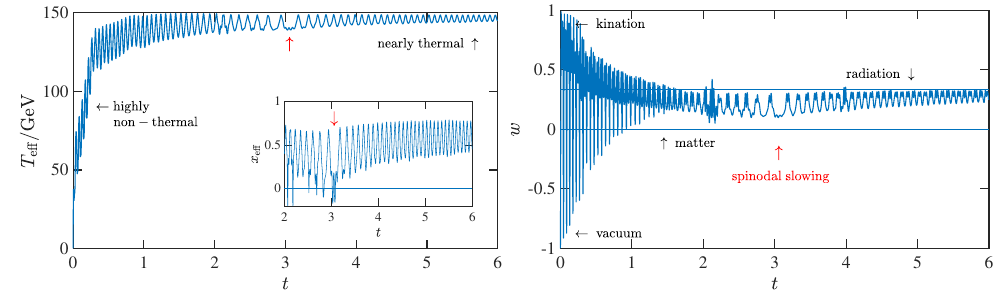
(cid:1)(cid:12) (cid:12) (cid:0) 1 / 2 /T . In the right panel m 2 (cid:12) m 2 eff (cid:12) eff